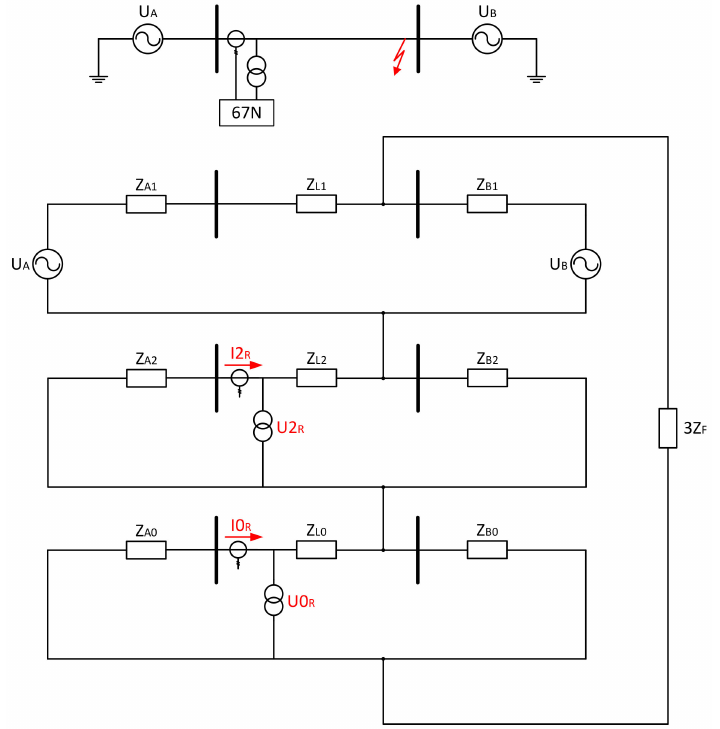
Figure 3. Example of sequence networks connection for a forward ground fault current and zero-sequence